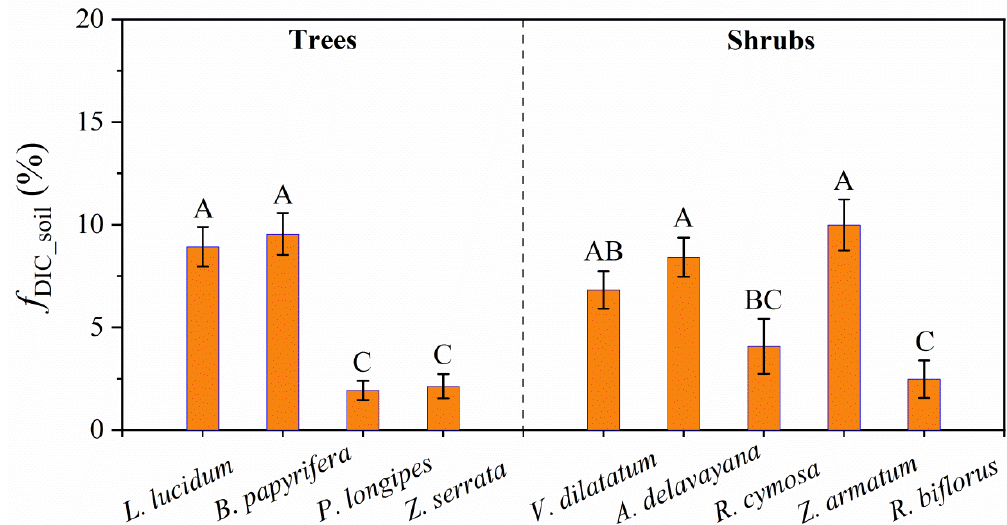
Figure 4. Contribution of soil DIC to leaf total photosynthesis ( f DIC_soil ) in nine species across three altitudes. N = 4 for each species in the specific plot. Capital letters on the error bar indicate significant differences ( p < 0.05) among species.